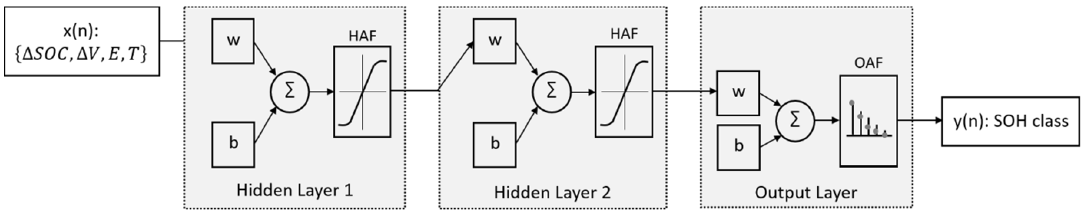
Figure 5. Pattern recognition a feed-forward artificial neural network (ANN) architecture for the SOH classification. HAF: hidden activation function. OAF: output activation function. w : weight. b : bias.